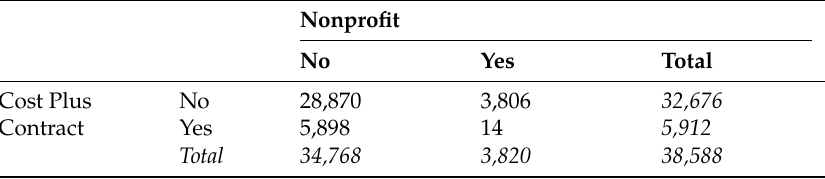
Table 2: Full sample tablulation by contract type.